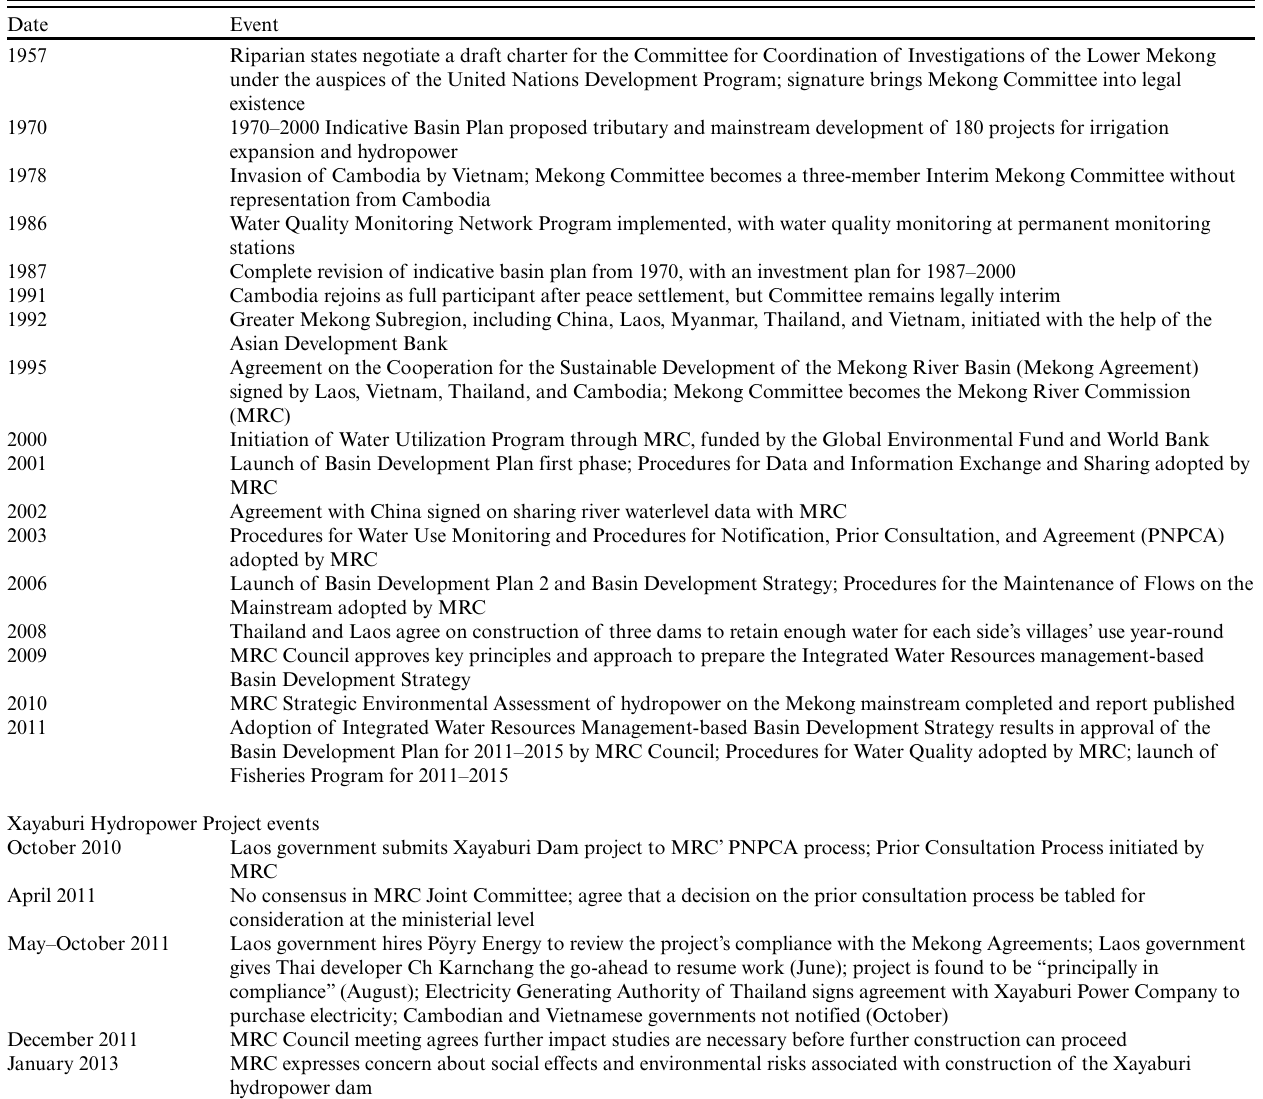
Table 1. Main events of the lower Mekong basin governance system and Xayaburi dam case. Sources: MRC (2010 e, 2013 c ), Bangkok Post (2014), Heikkila et al. (2014), Worrell (2014); International Rivers, Xayaburi dam: http://www.internationalrivers.org/campaigns/ xayaburi-dam; Wolf and Newton, unpublished report: http://www.transboundarywaters.orst.edu/research/case_studies/Documents/